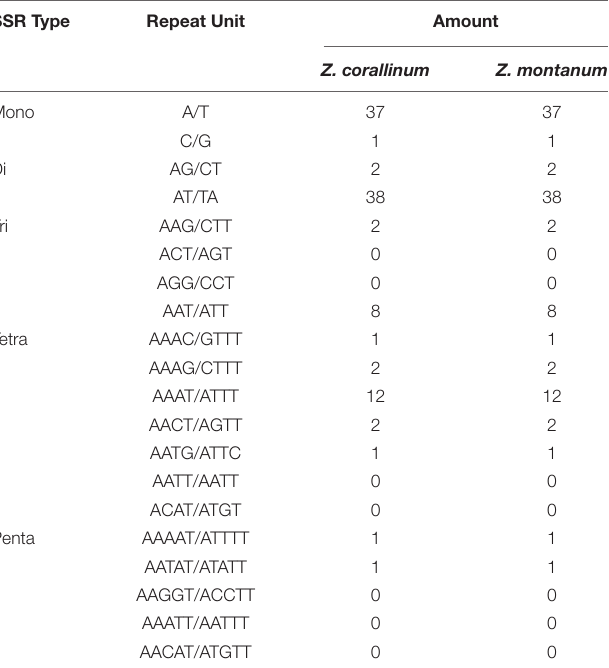
TABLE 1 | The general features of Z. corallinum and Z. montanum chloroplast genomes. Genome characteristics